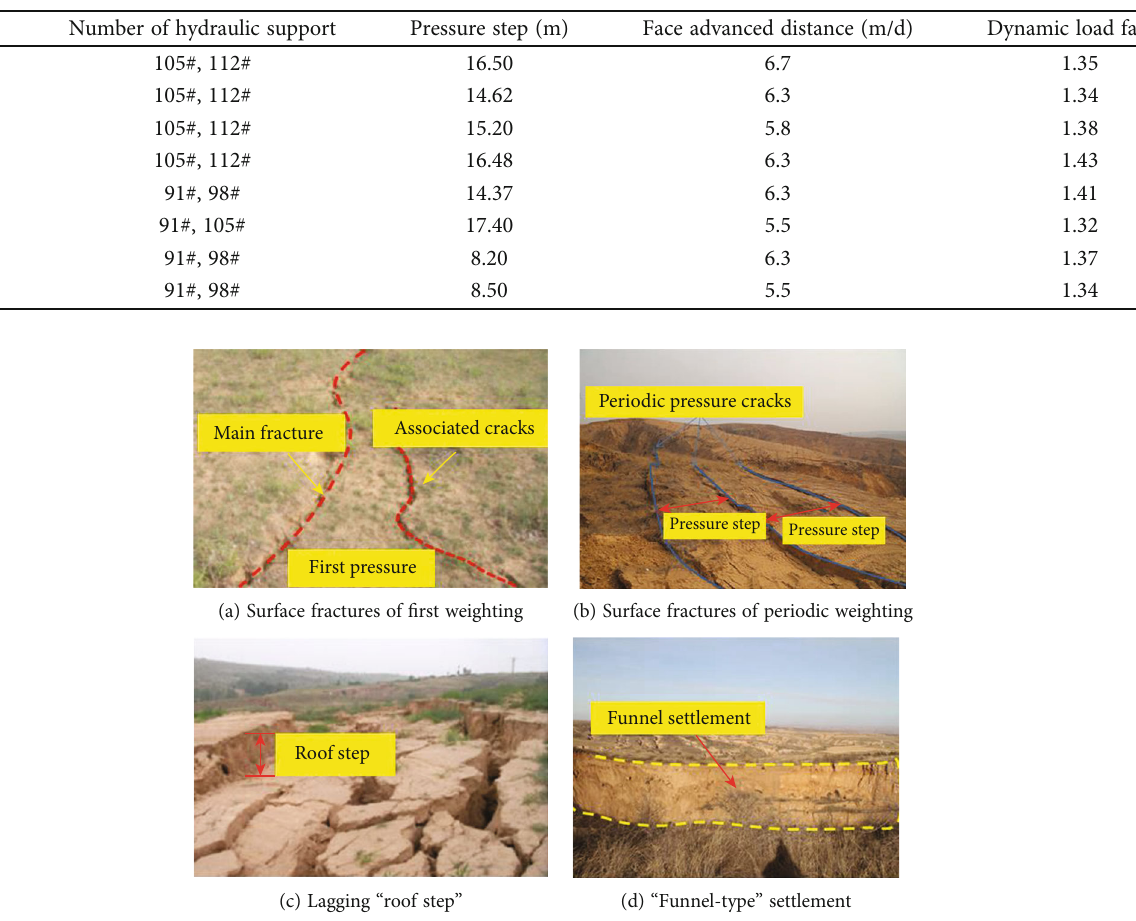
Table 6: Related data of working resistance of hydraulic supports (in the lower part of working face).